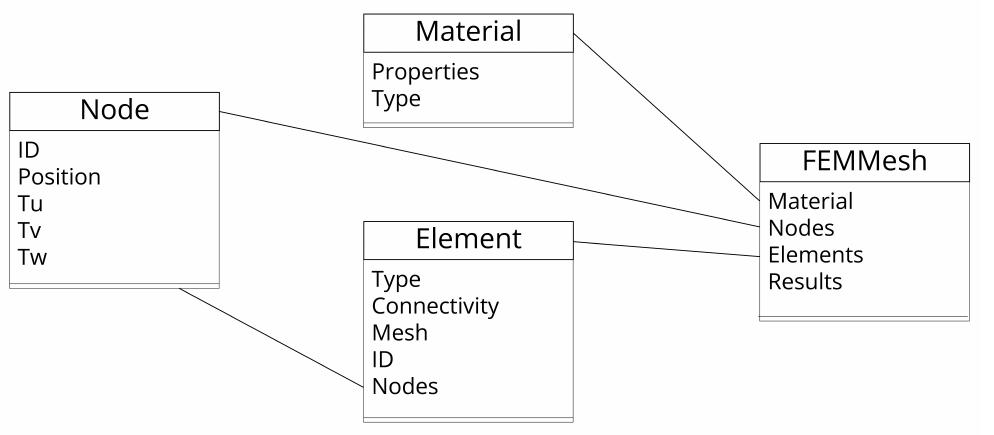
Figure 4. Class diagram showing the classes used to generate the